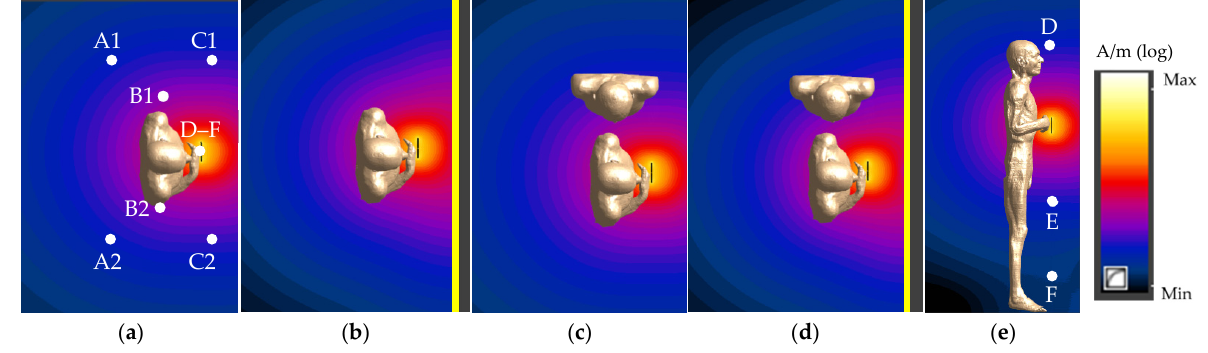
Figure 5. The normalised magnetic field distribution in a plane perpendicular to the centre of the HF RFID reader plane in various exposure scenarios: ( a , b , e ) the person using PICC device; ( c , d ) the person using PICC device and a bystander (reader on a vertical column ( a , c,e ) or attached to the vehicle cabin ( b , d ); horizontal ( a – d ) and vertical ( e ) cross-section; logarithmic scale).